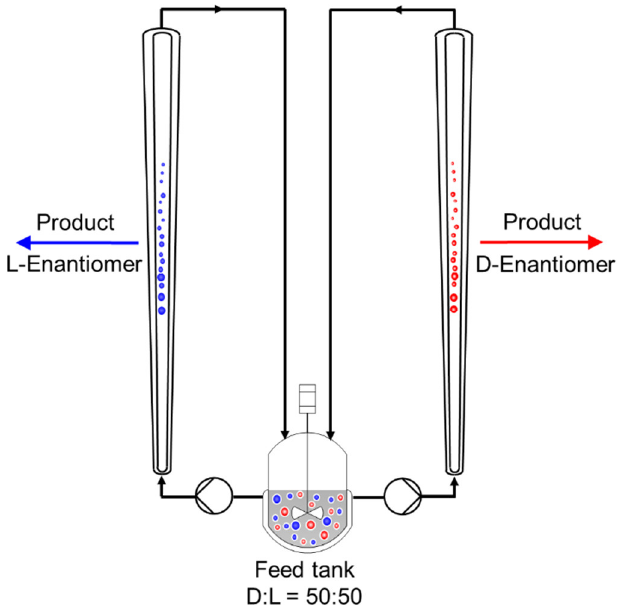
Figure 1. Principle scheme of a coupled Preferential Crystallization carried out in two fluidized bed crystallizers for the separation of the D- and L-enantiomer from the racemic (50:50) mixture provided in the feed tank (adapted from [2]).